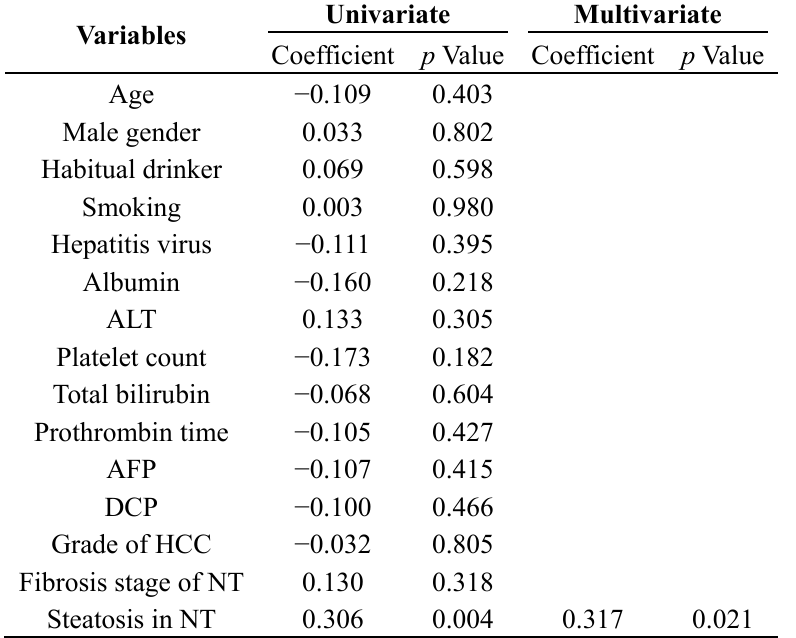
Table 2. Univariate and multivariate analysis of factors associated with AKR1B10 expression in non-tumorous liver